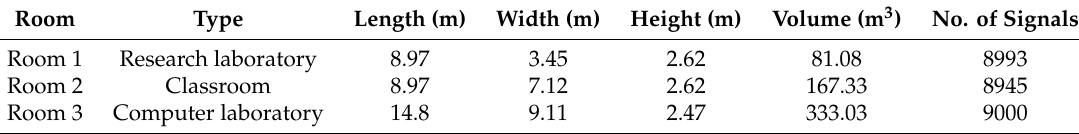
Table 2. Room types, dimensions, volumes, and total number of recordings per